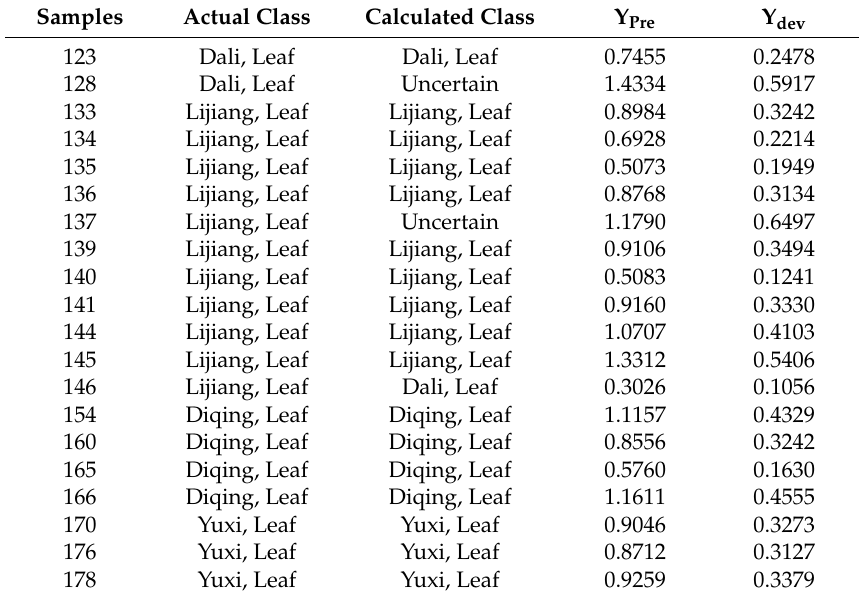
Table 4. Results of PLS-DA model 3 validate set samples.